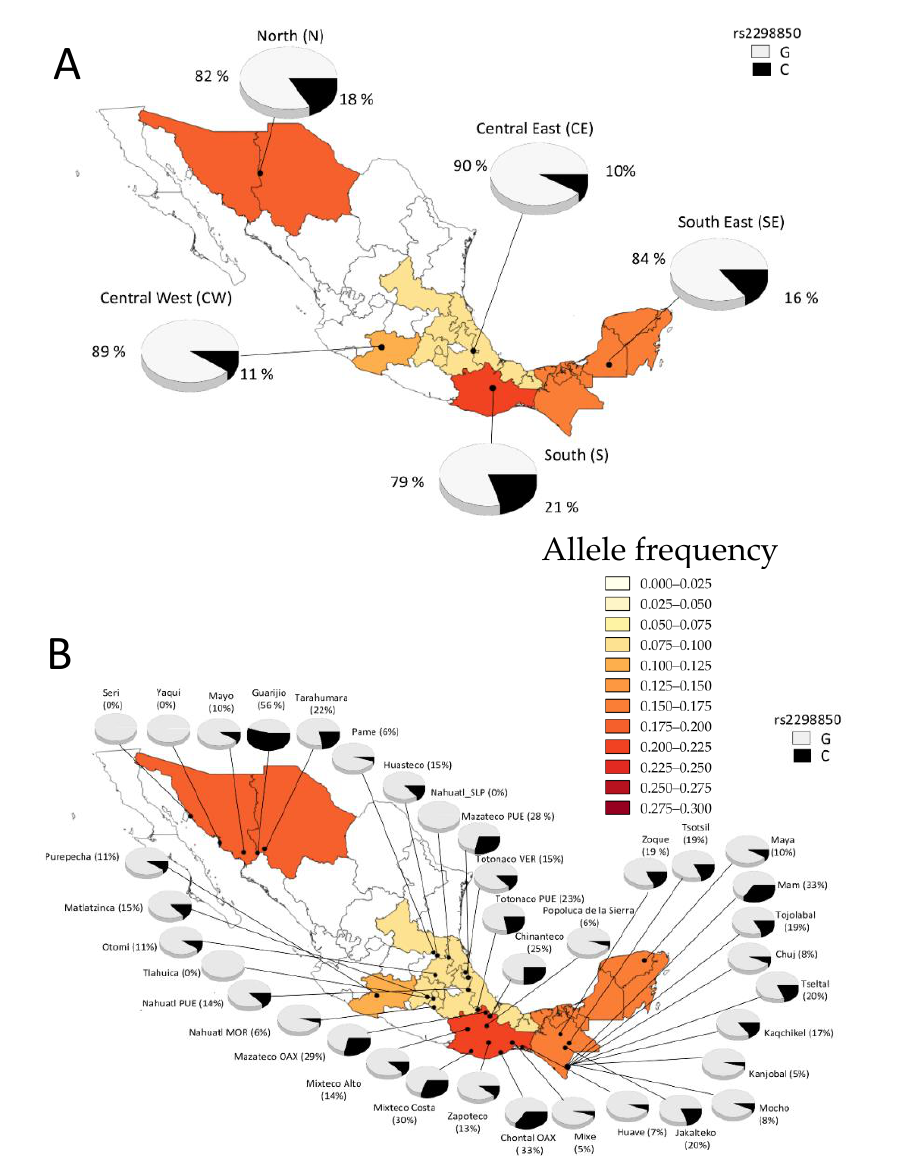
Figure 3. Geographic distributions of the allelic frequencies (G/C) for the rs2298850 polymorphism, (proxy for rs2282679) in the Mexican Amerindian groups. MEX, State of Mexico; MOR, Morelos; OAX, Oaxaca; PUE, Puebla; SLP, San Luis Potosi, VER, Veracruz. ( A ) Distribution of the allelic frequencies for the rs2298850 polymorphism within each geographic region. ( B ) Allelic frequencies for the rs2298850 polymorphism in the Amerindian groups.